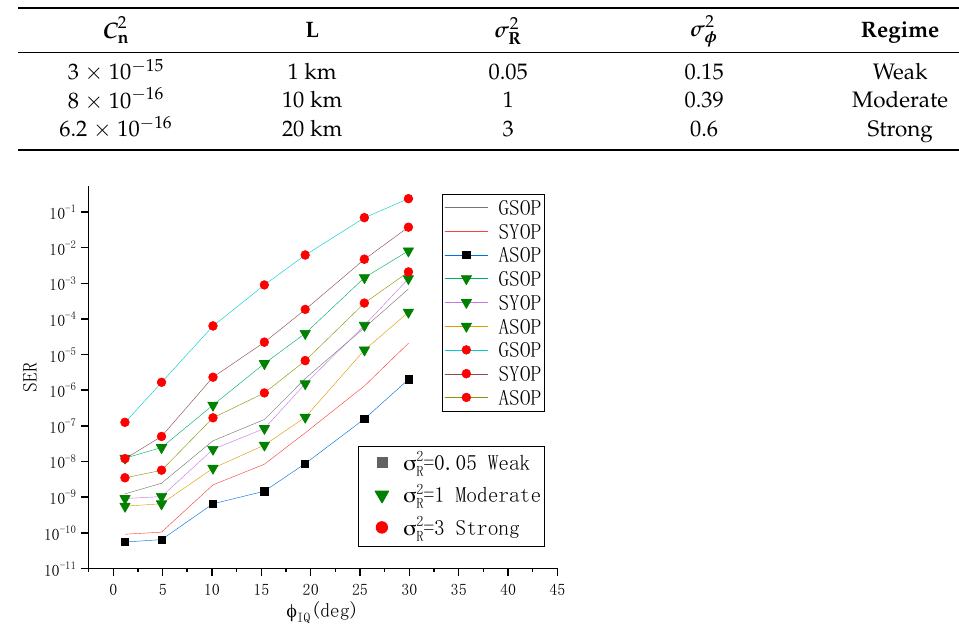
Table 3. Parameters used in the numerical simulation, as shown in Figure 11.